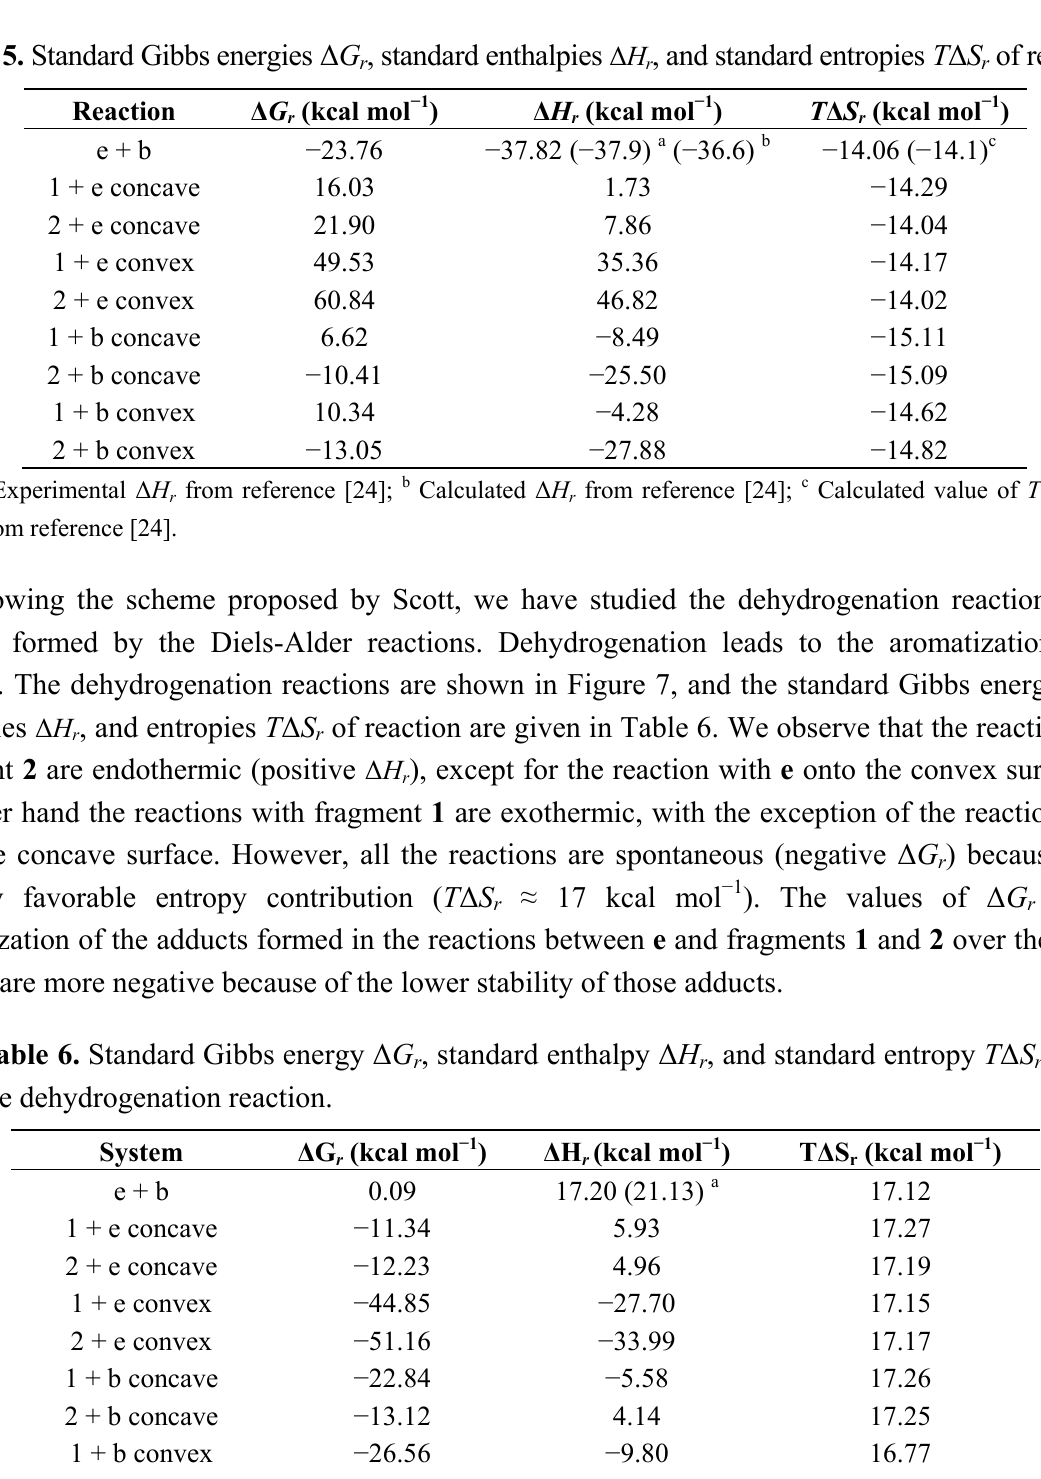
Table 5. Standard Gibbs energies Δ G